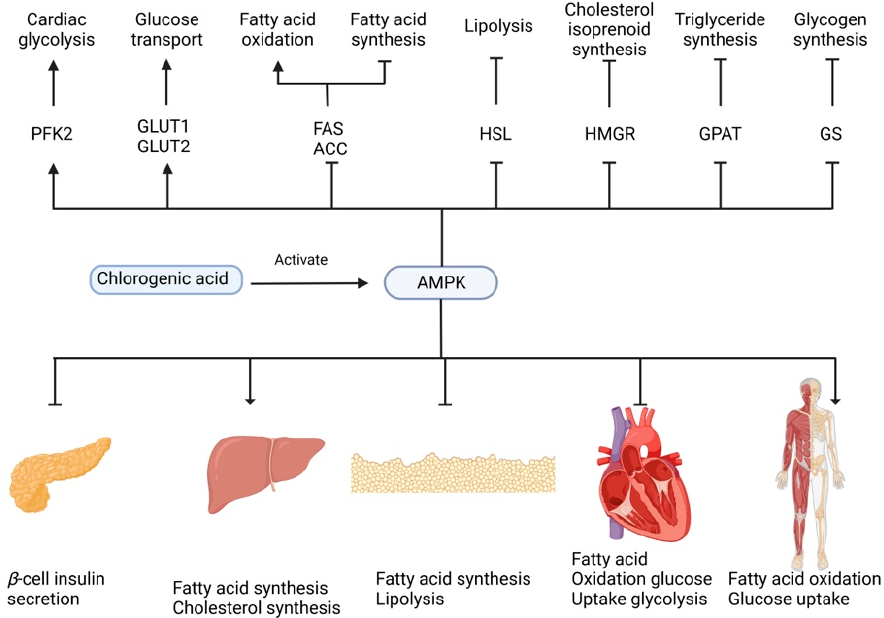
Figure 3. 5CQA-mediated regulation of glucose and lipid metabolism through activation of the AMPK pathway.